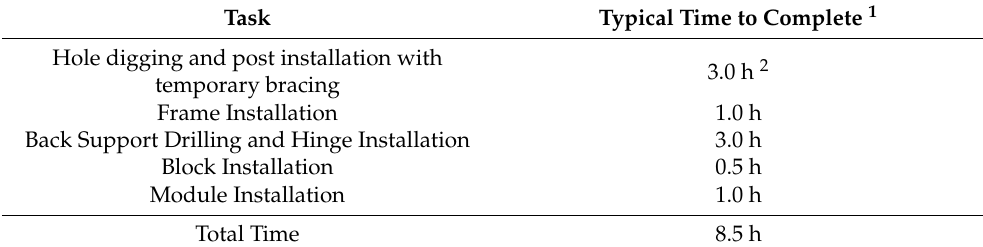
Table 3. Time invested in building the multi-tilt racking system.